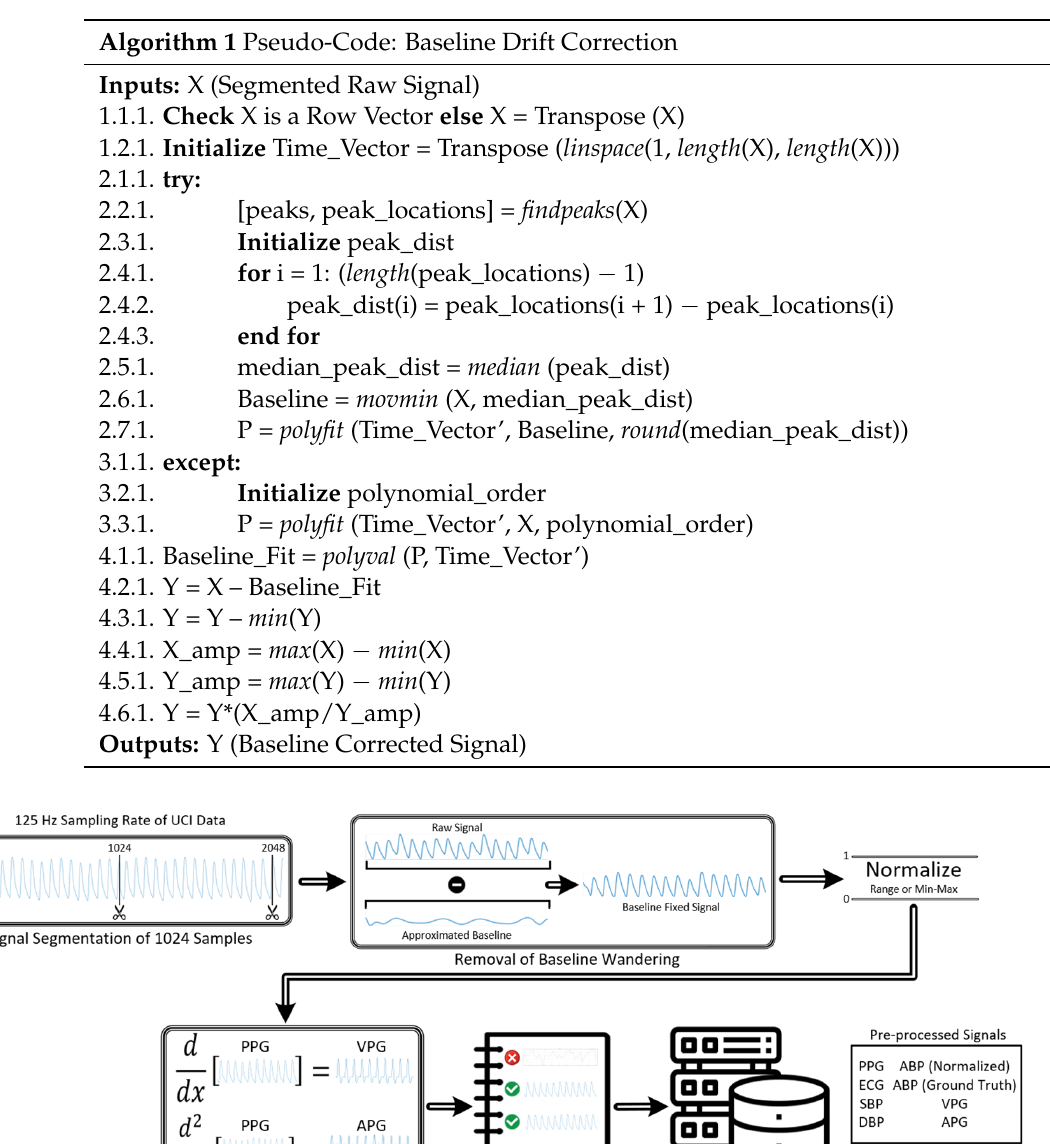
Algorithm 1 Pseudo-Code: Baseline Drift Correction Inputs: X (Segmented Raw Signal)